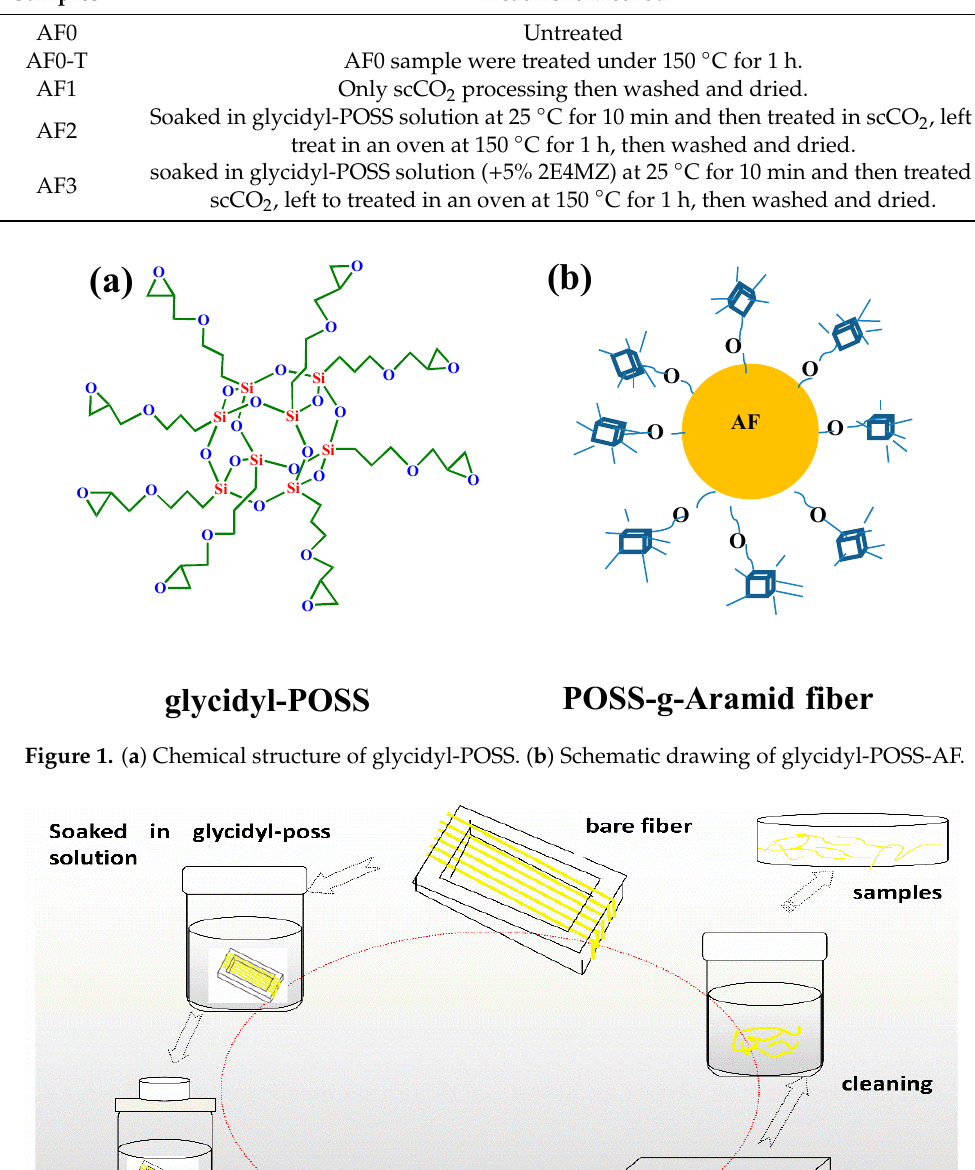
Figure 3. Scheme of the modification process. 2.3. Characterizations The surface chemical modification of the modified AF was studied using FT-IR (Nicolet 8700, Thermo Fisher Scientific, Waltham, MA, USA), which provided the information about various chemical bonds. TGA was performed on the Thermogravimetric Analyzer (TGA, Q50, DuPont, Delaware, MD, USA) in nitrogen at a ramp rate of 10 °C/min. The samples were analyzed in the range of 80–800 °C. XRD analyses were performed by using a diffractometer with the type of X Pert PRO from Panalytical, Netherlands. Test conditions are following: Cu-Ka radiation, tube voltage with 40 KV, tube current with 40 mA. Scan range from 10 to 40, scan rate with 2/min. In addition, the XPS tests were conducted by X-ray photoelectron spectroscopy (Thermo fisher Scientific, K-Alpha + , Waltham, MA, USA). The microstructure of the samples was studied by using field emission scanning electron microscopy (Sirion 200, FEI, Hillsboro, OR, USA). Atomic force microscopy